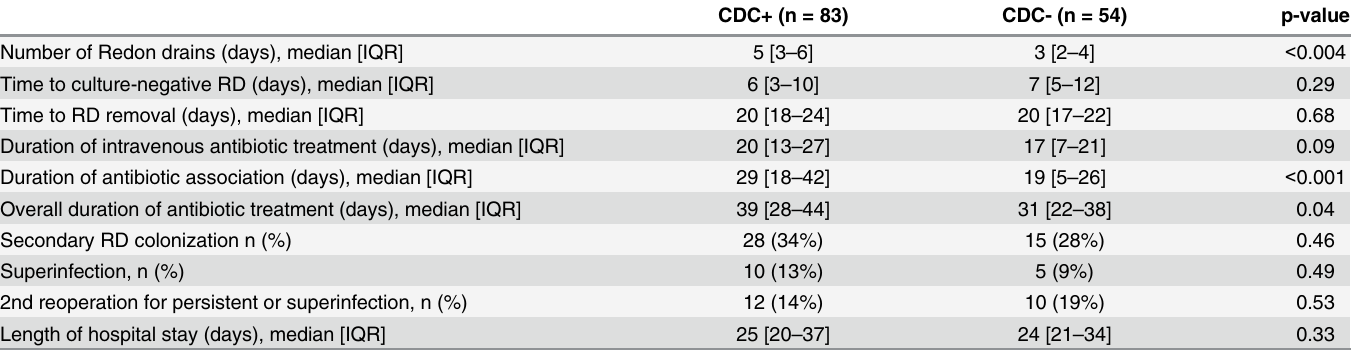
Table 3. Surgical and Medical Management in 137 Patients with Sternal Wound Infection Requiring Reoperation after Cardiac Surgery according to the